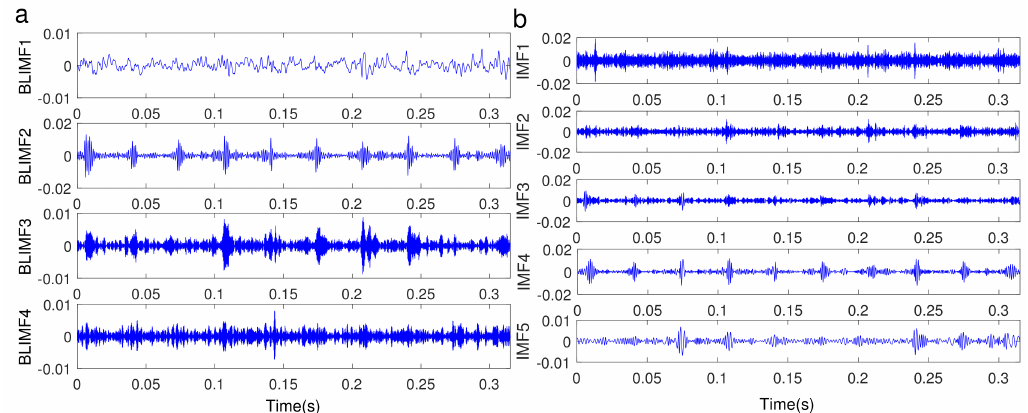
Figure 17. The decomposed BLIMFs using VMD ( a ) and IMFs using EMD ( b ) from the signal of the gear with a chipped tooth.